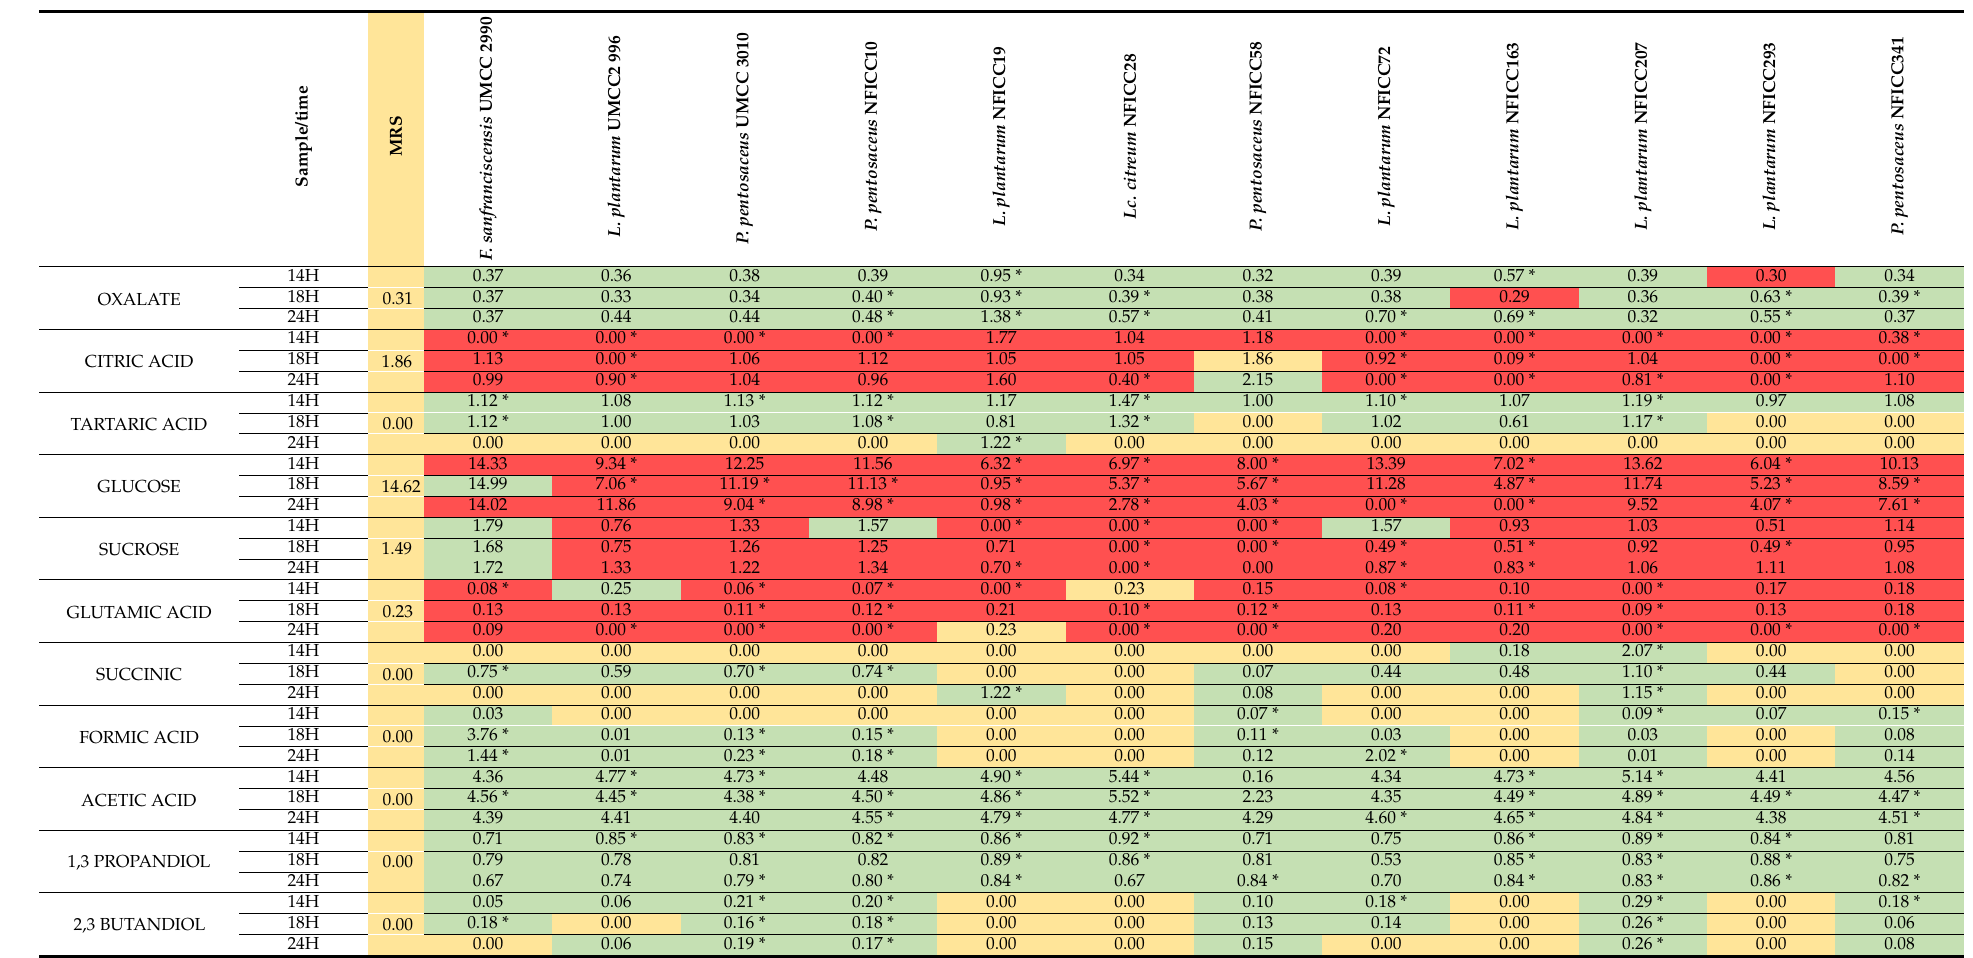
Table 3. Different compounds (g/L) detected by HPLC after 14, 18, and 24 h of fermentation in MRS broth. The creation of the heat map is based upon the detected MRS broth concentration: green color highlights the production, red color the consumption, and yellow color was used when the detected amount was equal to MRS broth. The measurement were with three independent experiments, and Kruskal–Wallis statistical analysis was performed to detect the significant strains with respect to plain MRS. The significance is marked with an